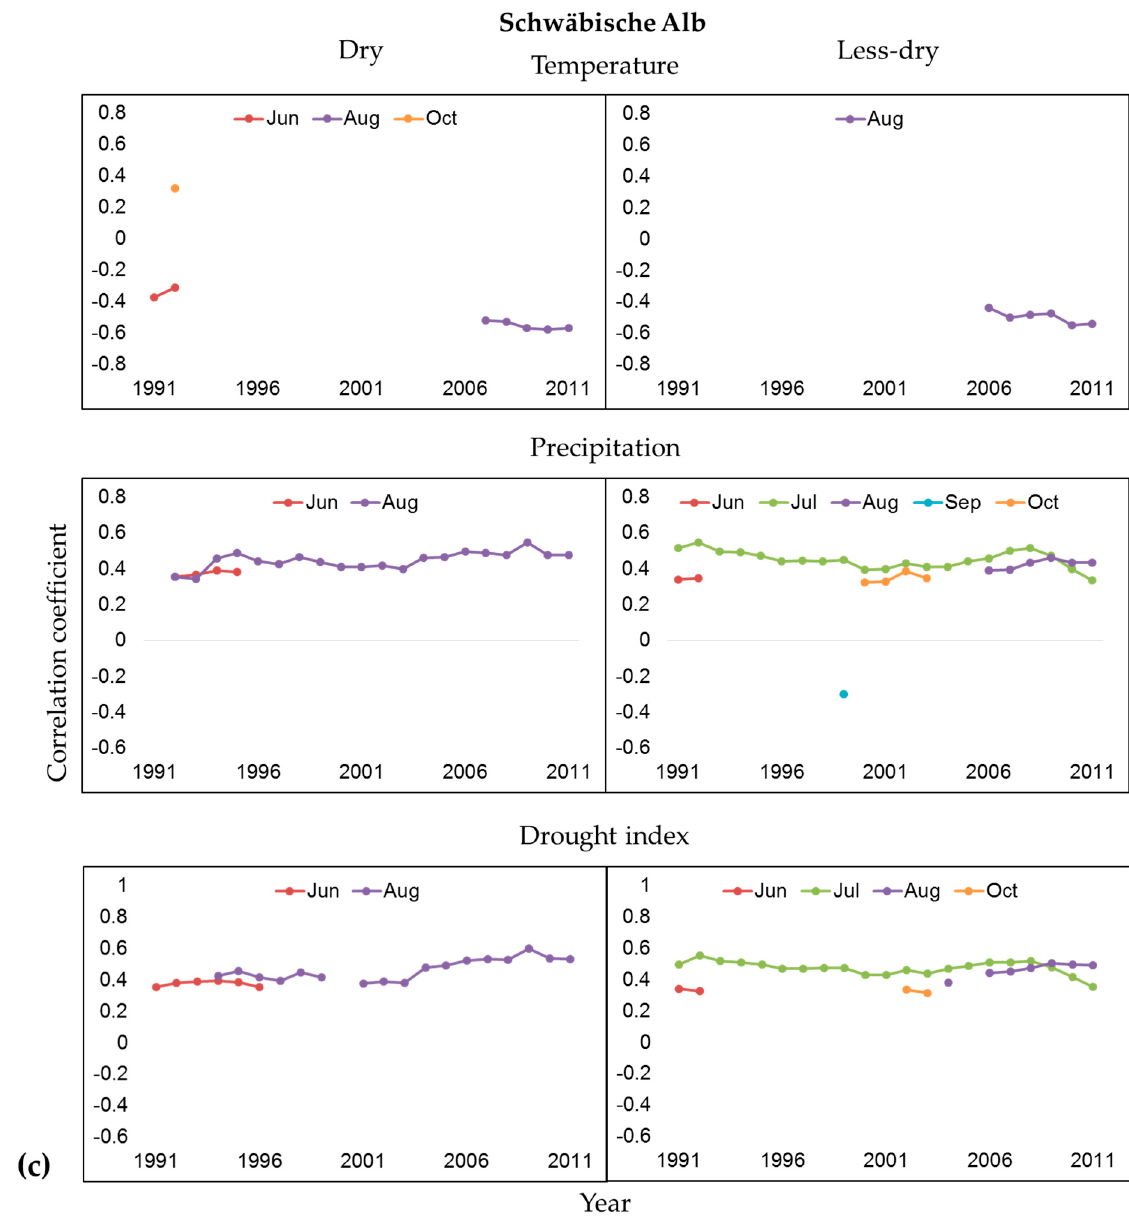
Figure 7. Correlations between radial tree growth and climatic parameters at a temporal scale separately for dry and less-dry plots in ( a ) Badenweiler, ( b ) Klettgau, and ( c ) Schwäbische Alb. Residual tree ring width indices were used as the dependent variable, whereas monthly (May to October of the previous calendar year of the growth) temperature, precipitation, and drought index (P–PET) were used as the independent variables. Only months with significant relations are shown in the graphs. For Badenweiler and Klettgau, the correlation analysis was run for the period of 1951 to 2011 with the moving window base length of 30 years, which generated results for the period of 1981 to 2011; for Schwäbische Alb, the correlation analysis was run from 1961 to 2011 with the same moving window base length of 30 years which generated results for the period of 1991 to 2011.